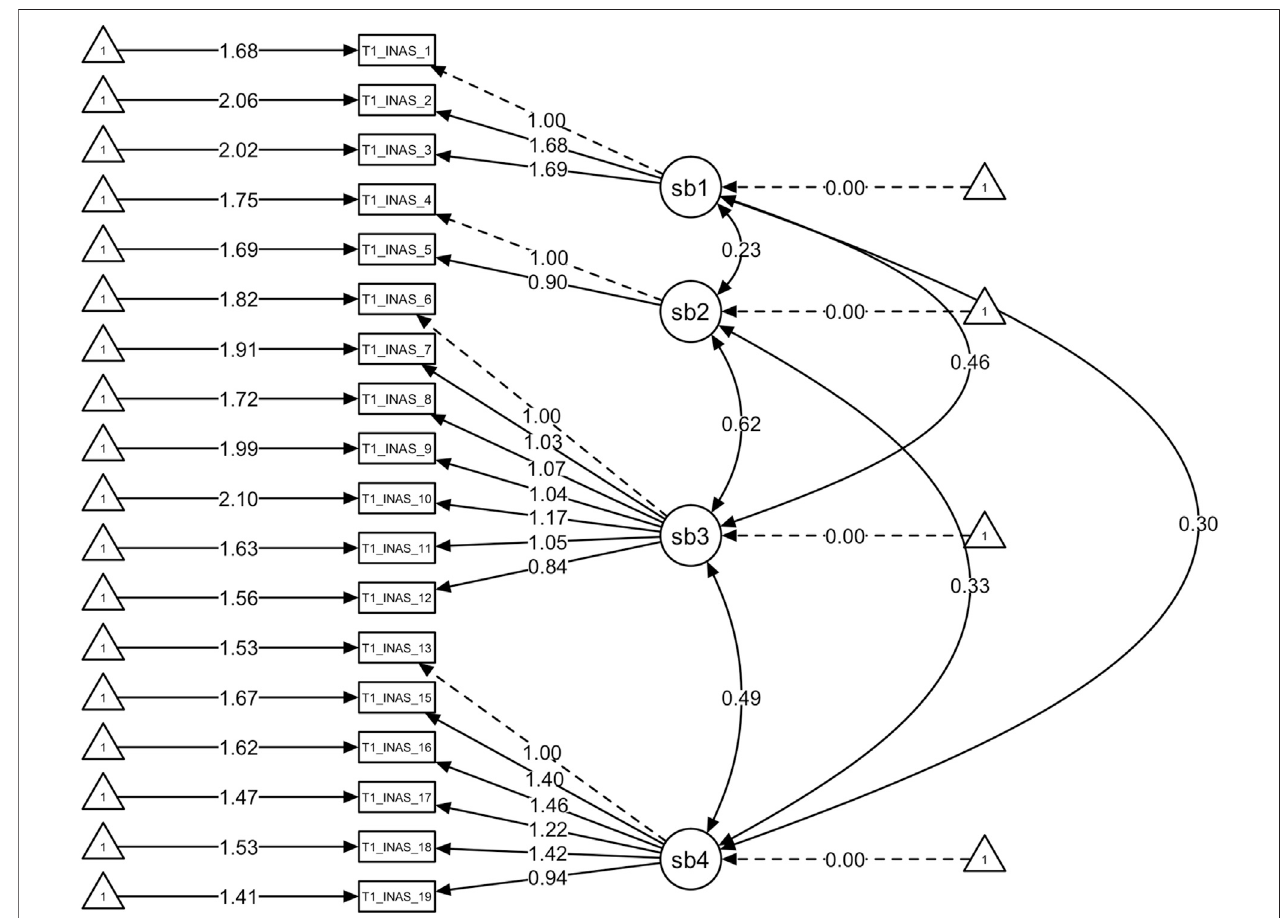
FIGURE 1 | Con fi rmatory factor analysis using structural equations models for the portuguese version of INAS: models assessed and their respective fi t indexes.